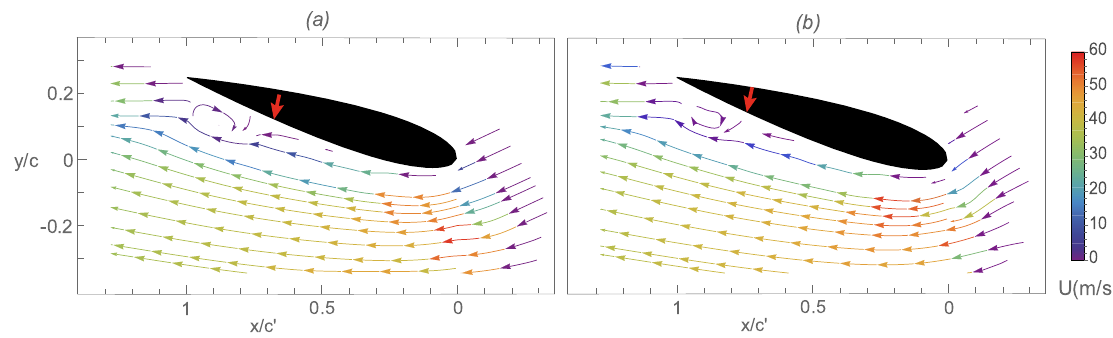
Figure 17. ( a ) Plasma-off and ( b ) plasma-on flow field at T C for α = 14.5 ◦ and U ∞ = 30 m/s.